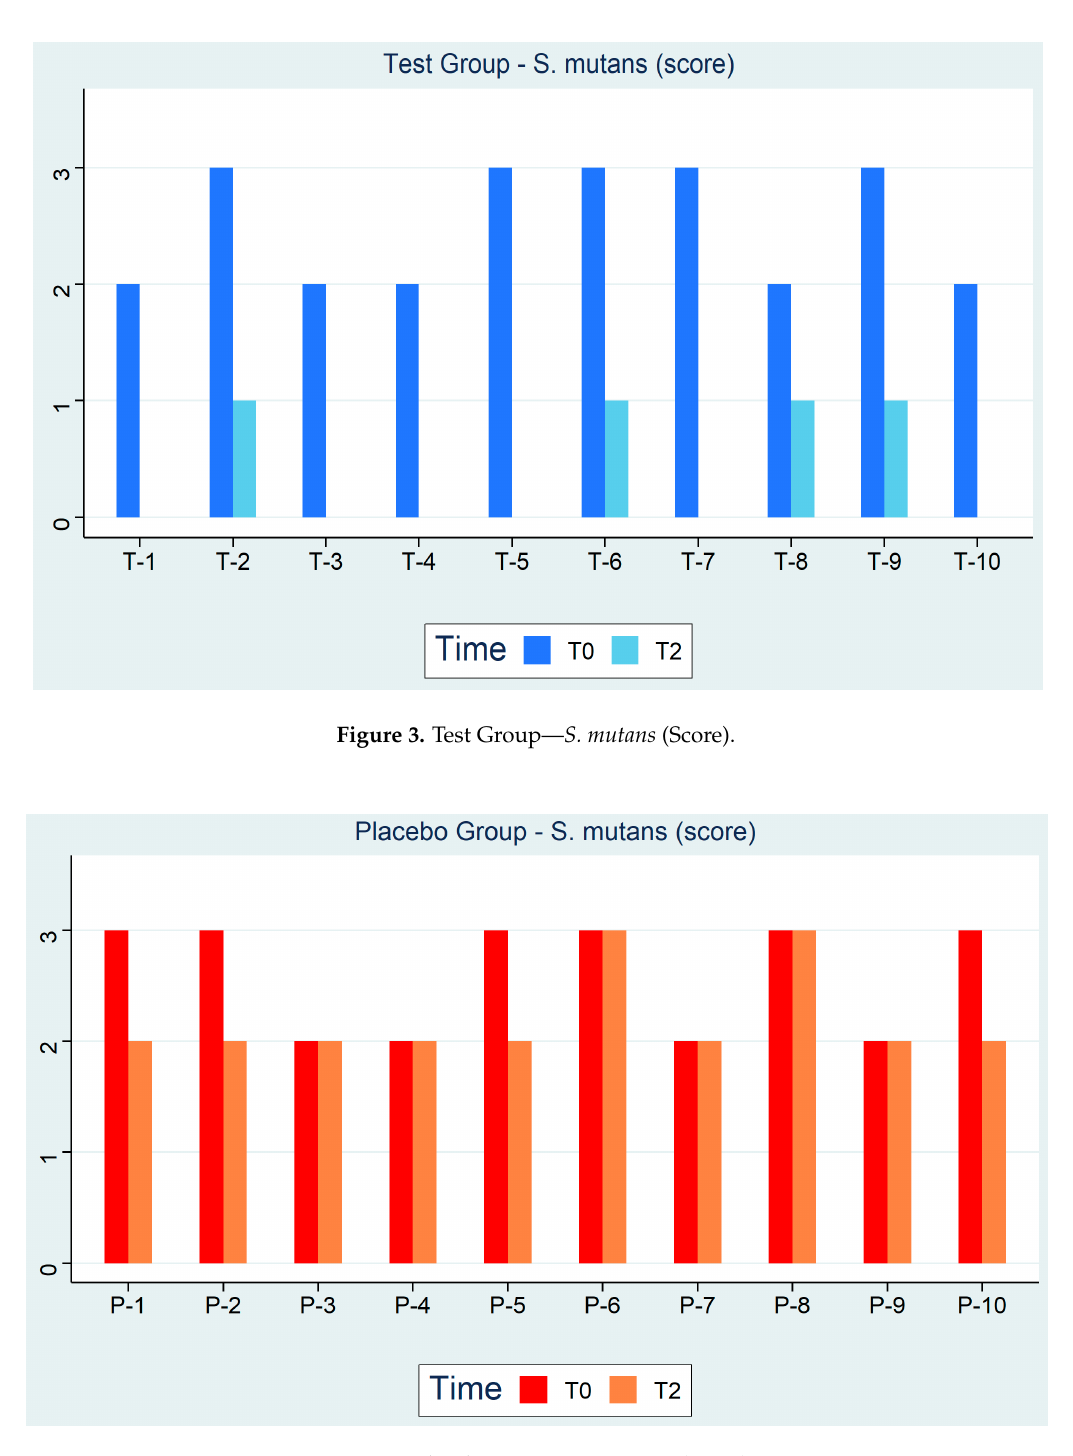
Figure 4. Placebo Group— S. mutans (Score). Table 4. Wilcoxon test p -values.